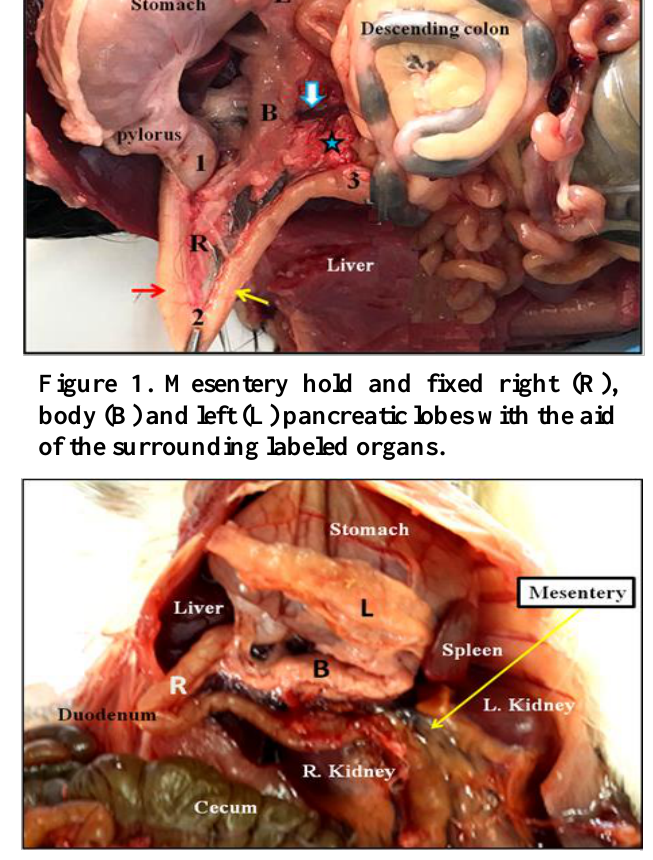
Figure 2. In situ pancreatic lobes such as right (R), body (B) and left (L), part of body connected to ascending duodenum (blue star), descending duodenum (red arrows), ascending duodenum (yellow arrow), portal vein (white arrow), 1st (1), 2 nd (2) and 3 rd (3) duodenal